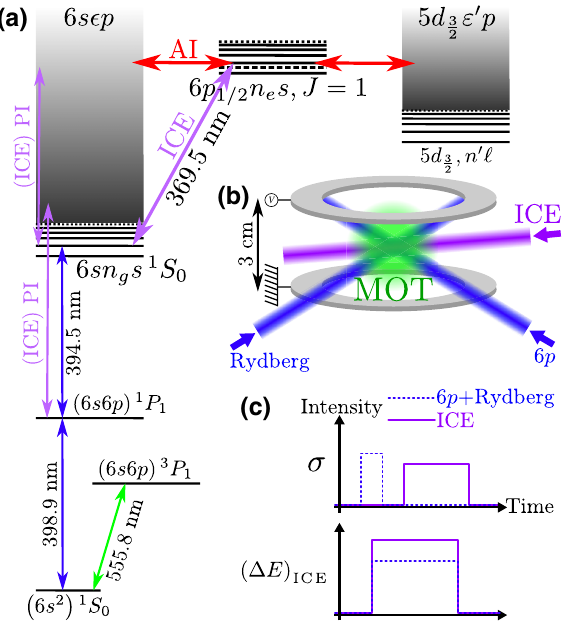
FIG. 3. (a) The energy-level diagram of 174 Yb related to the experiment and couplings between them. The purple arrows show the ICE light coupling atoms in 6 sn g s 1 S 0 states to the 6 p 1 / 2 n e s , J = 1 Rydberg series. The red horizontal arrows show the coupling of this doubly excited series to the two continua 6 s (cid:3) p and 5 d 3 / 2 (cid:3) (cid:2) p , which are responsible for AI. Possible direct photoionization (PI) processes induced by ICE light are also shown (purple vertical arrows). (b) The laser and electrode con- figuration around the MOT. (c) The scheme of the laser pulse sequences applied before recording N ion and N R , for the ICE spectra measurements (yielding the cross section σ ) and for the . ICE light-shift measurements, yielding ((cid:4) E ) ICE (cid:2) (cid:3) ↔ ( 6 s 6 p ) 3 P 1 S trap (MOT) operated on the 6 s 2 0 1